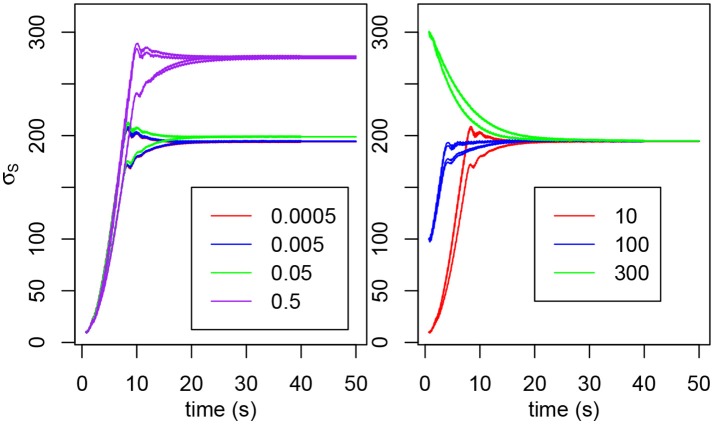
(Left) Evolution of σs2E, σs2F, σs3E, and σs3F for various values of W. The initial value is 10 for each σs. (Right) Evolution of σs3E and σs3F for various initial values (in red, 10; in blue, 100; in green, 300). The σs have not been distinguished because we're only interested in the tendency and not in the individual behaviors.